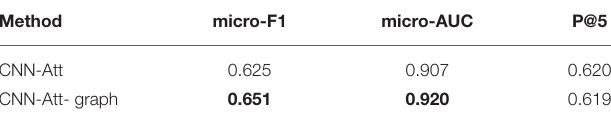
TABLE 5 | The experimental results of the top-50 codes. TABLE 6 | The result of universality